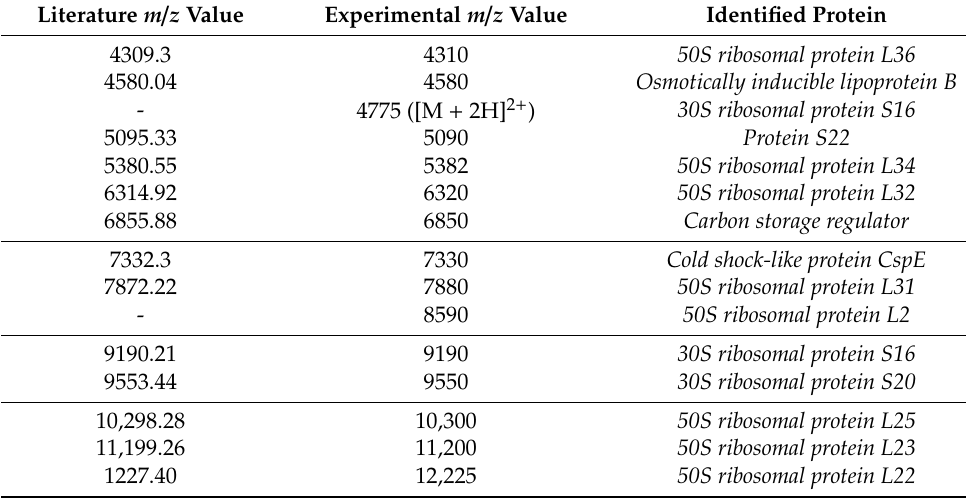
Table 1. Proteins identified after matching the experimental m / z values obtained in MALDI-TOF mass spectra of E. coli cell samples with selected m / z from literature [32,58] after a Swiss-Prot / TrEMBL database